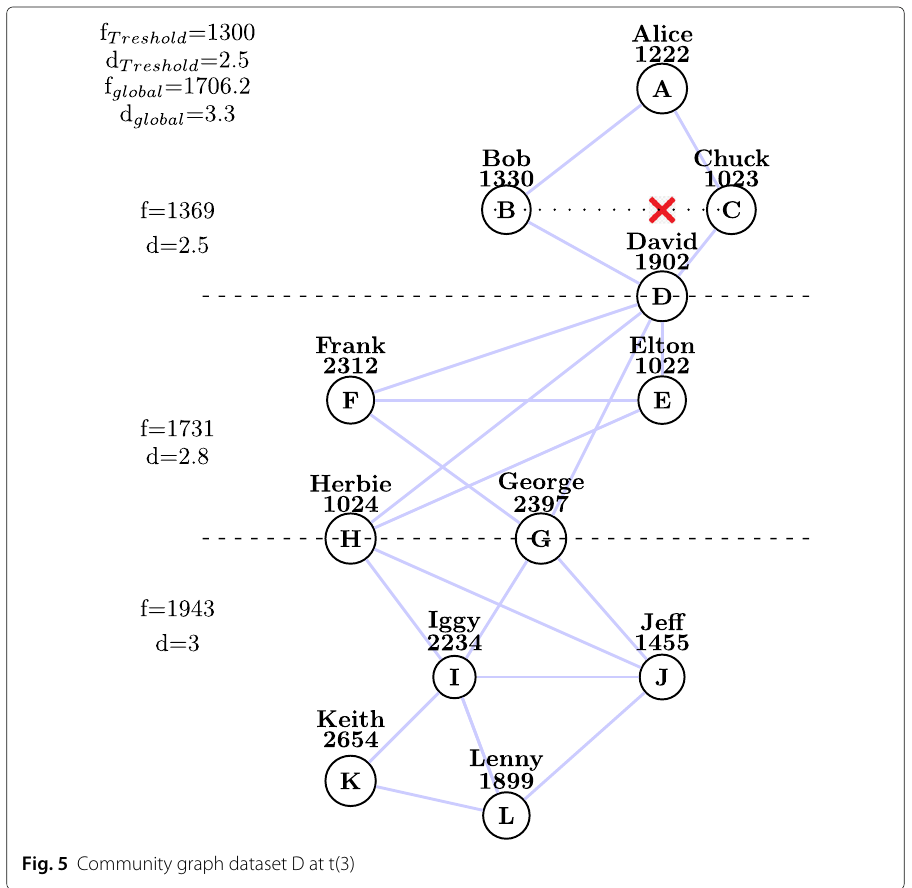
Fig. 5 Community graph dataset D at